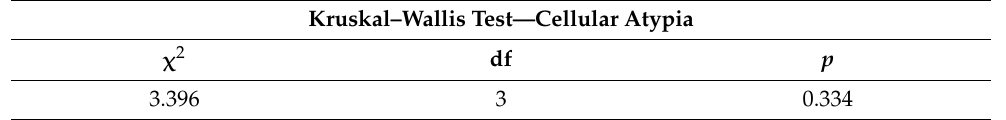
Table 13. Kruskal-Wallis test for “cellular atypia” variable.